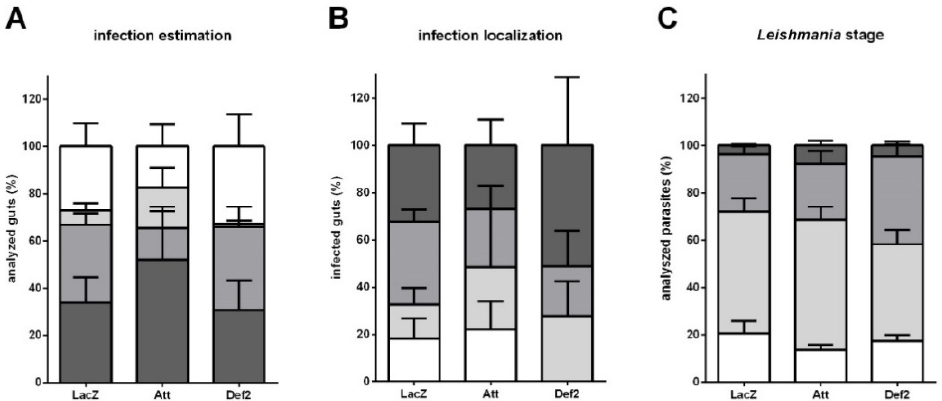
Figure 5. Infection intensity and development at late infection in dsRNA-injected sand flies. ( A ) The y -axis represents the percentage of all individually inspected insects (minimum of 20 sand flies in each dsRNA injected group). Bar colors indicate infection intensity: non-infected (white); with low (light grey); medium (mid grey); and heavy (dark grey) infections. ( B ) The y -axis represents the percentage in infected insects to measure the infection progress in the gut. Bar colors indicate sand fly gut localization: parasites reached the stomodeal valve (dark grey); cardia (mid grey); thoracic gut (light grey); or stayed in abdominal gut (white). ( C ) The y -axis represents the percentage of analyzed parasites to measure parasite development in the sand fly gut. Bar colors indicate parasite developmental stage: metacyclic promastigote (dark grey); leptomonad (mid grey); elongated nectomonad (light grey); procyclic promastigote (white). The x -axis represents dsRNA injected groups. Vertical bars represent the average values of three independent experiments, and error bars represent the standard error. No significant differences were found.